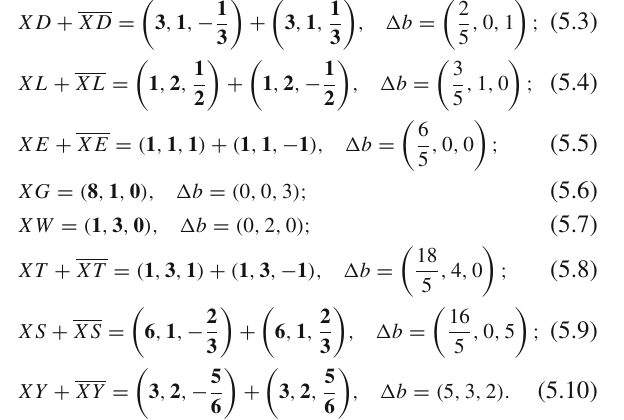
Fig. 1 Gauge coupling unification at 1 . 39 × 10 16 GeV for Model 1